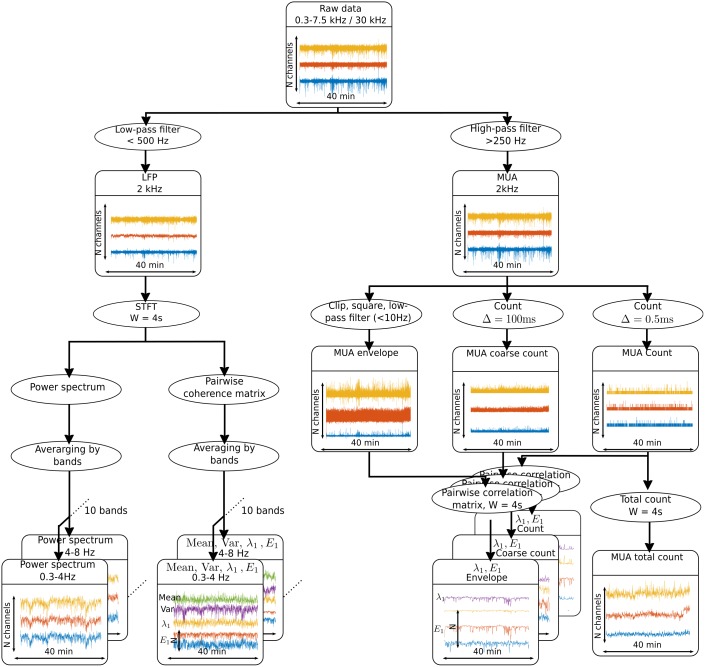
Processing pipeline for extracting features from the MEA recorded signals.The broadband field potential signal is low-pass and high-pass filtered to obtain the LFP and the MUA, respectively. For LFP (left), a short-term Fourier transform (STFT) was applied to obtain the power spectrum, as well as the mean, variance, and leading eigenvalues and eigenvectors of the pairwise spectral coherence matrix averaged over frequency for each frequency band. For MUA (right), the count for each channel, the total count across channels, as well as the leading eigenvalues and eigenvectors of the pairwise correlation matrices for the MUA envelope, the coarse MUA count and the MUA count were computed.